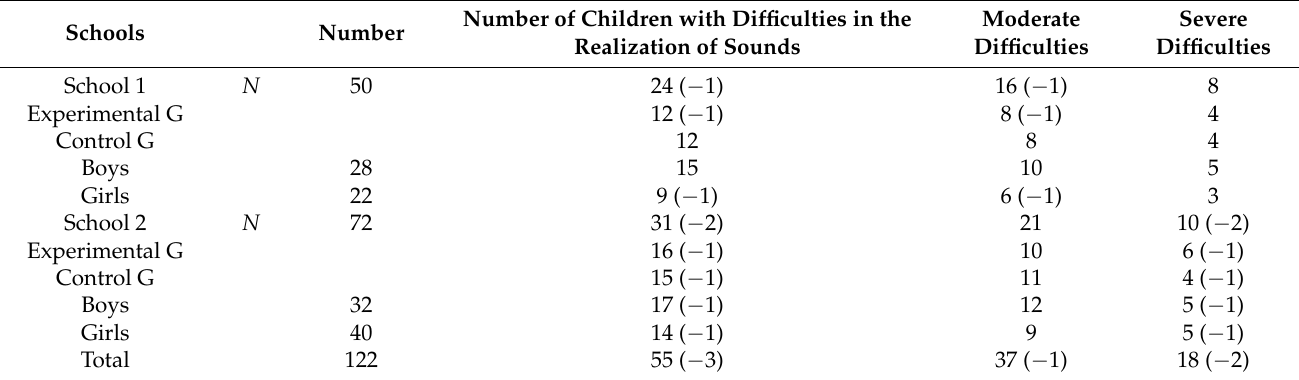
Table 1. Distribution of participants by school and experimental and control